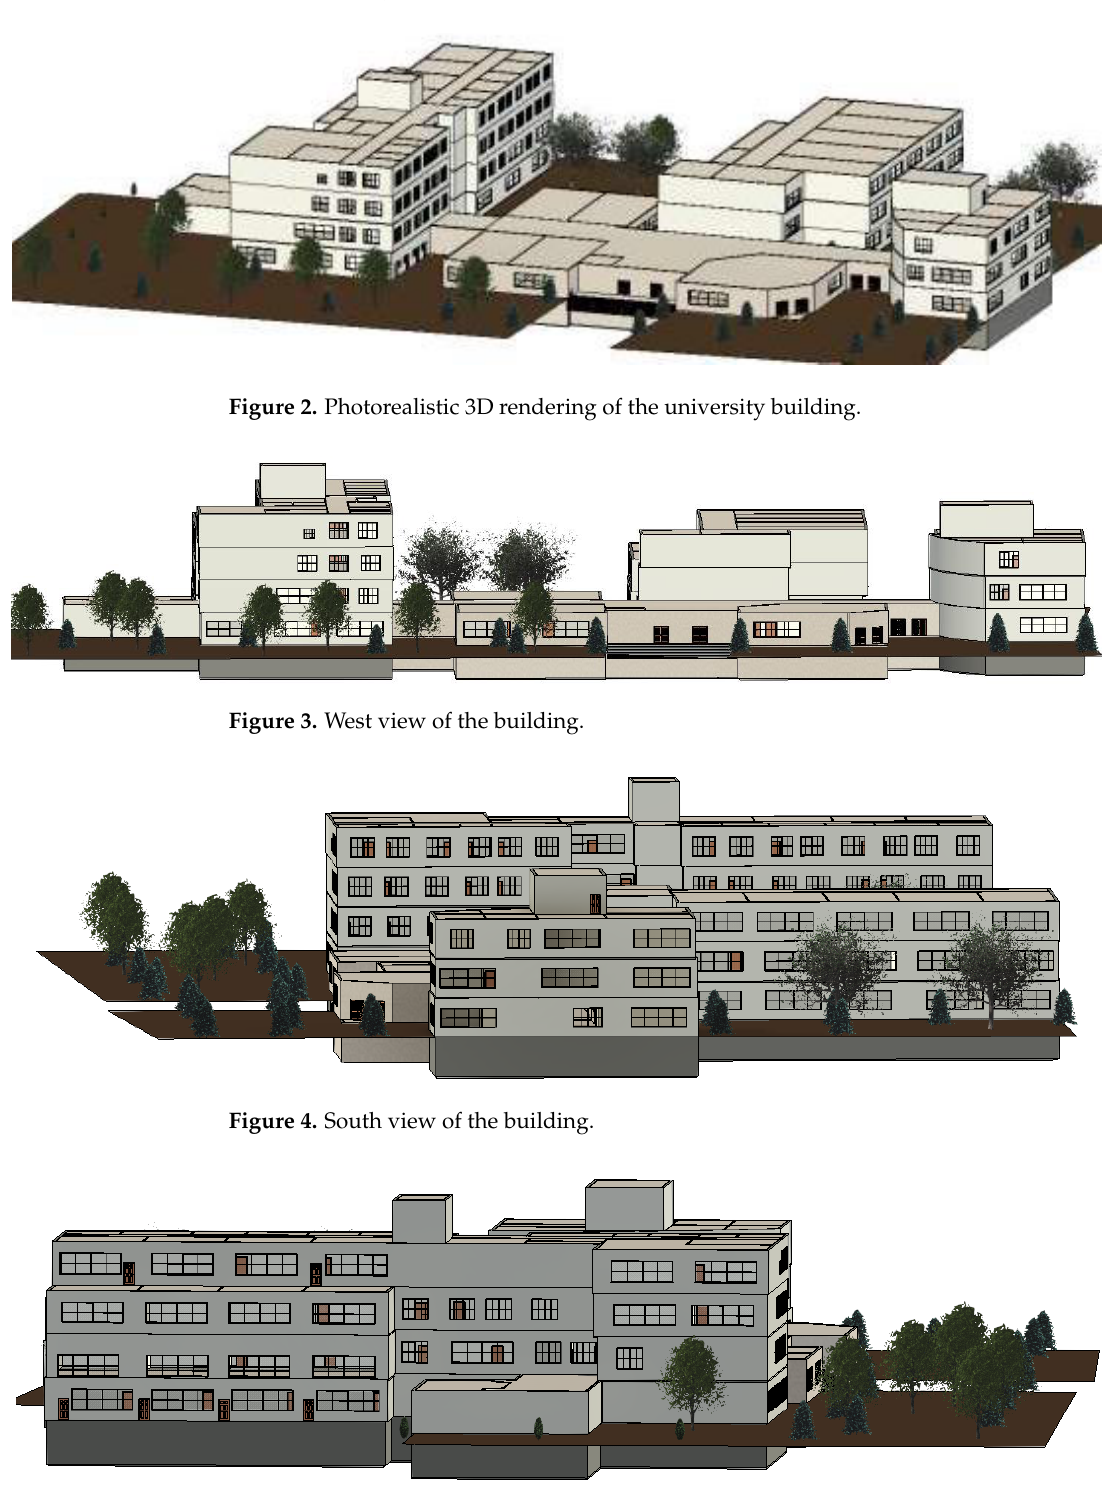
Figure 5. North view of the building.